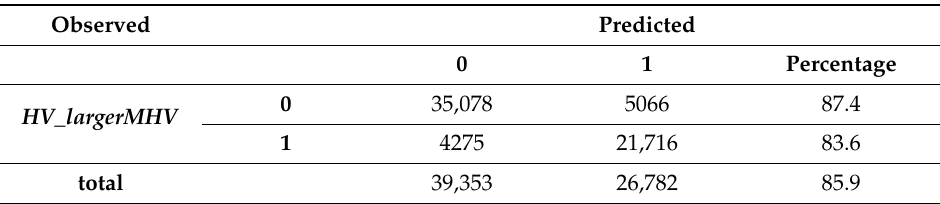
Table 5. Classification table of the logistic regression